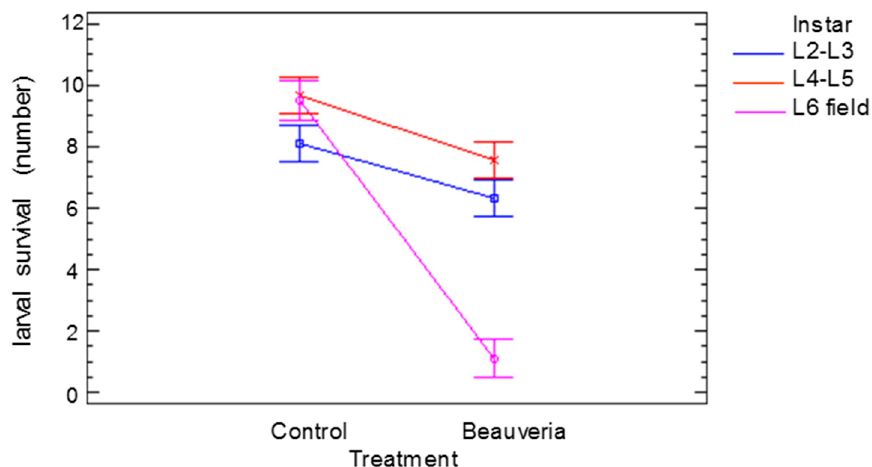
Figure 3. Significant effect ( p < 0.05) of Cydalima perspectalis larval age (instar) treatment interaction on larval survival. Bars show the least significant differences.